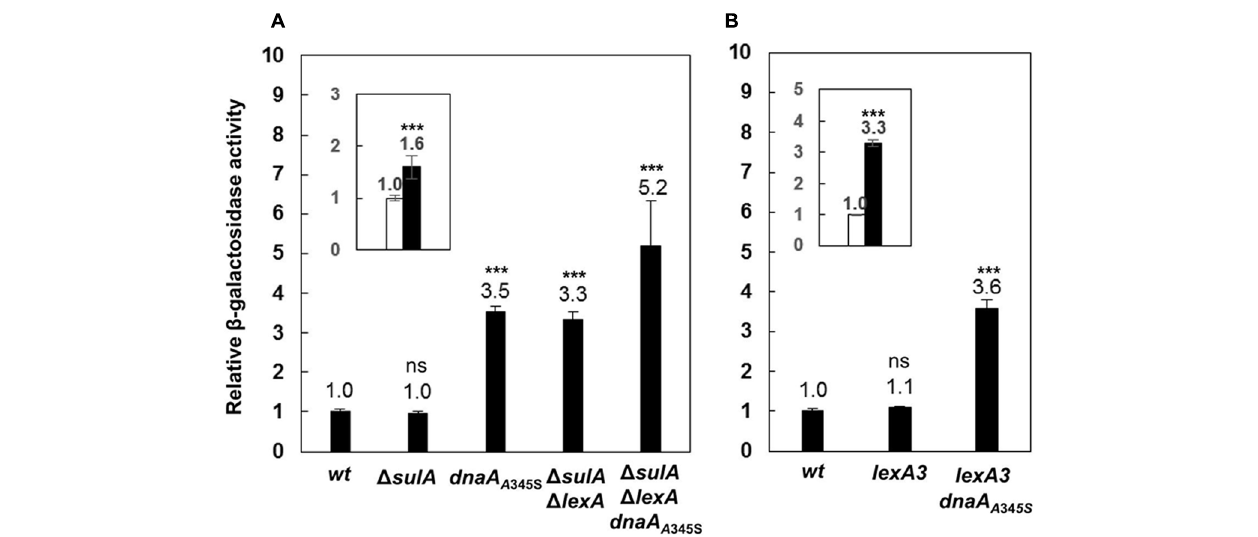
FIGURE 1 | The DnaA and LexA proteins repress expression of the uvrB gene independently. (A) The wild-type, (cid:49) sulA, dnaA A345S , (cid:49) sulA (cid:49) lexA and (cid:49) sulA (cid:49) lexA dnaA A345S cells carrying uvrB - lacZ fusion on their chromosomes were exponentially grown in ABTGcasa medium at 37 ◦ C. The β -galactosidase activity from uvrB - lacZ fusion in the cells was determined by Miller method (Miller, 1972), and relative expressions of uvrB-lacZ in all mutants to that in the wild-type (14 U) were calculated. The inset indicates the relative expression of uvrB-lacZ in the (cid:49) sulA (cid:49) lexA dnaA A345S cells against that in the (cid:49) sulA (cid:49) lexA cells. (B) The β -galactosidase activity in exponentially growing lexA 3 and lexA 3 dnaA A345S cells carrying uvrB - lacZ fusion was determined as described in the legend to (A) . The inset indicates the relative expression of uvrB-lacZ in the lexA 3 dnaA A345S cells against that in the lexA 3 cells. The values shown at top of the bars are the average of three individual experiments, and the standard errors are shown. ∗∗∗ Stands for P -value ≤ 0.01, ∗∗ for 0.01 < P -value ≤ 0.05, and ns represents P -value >